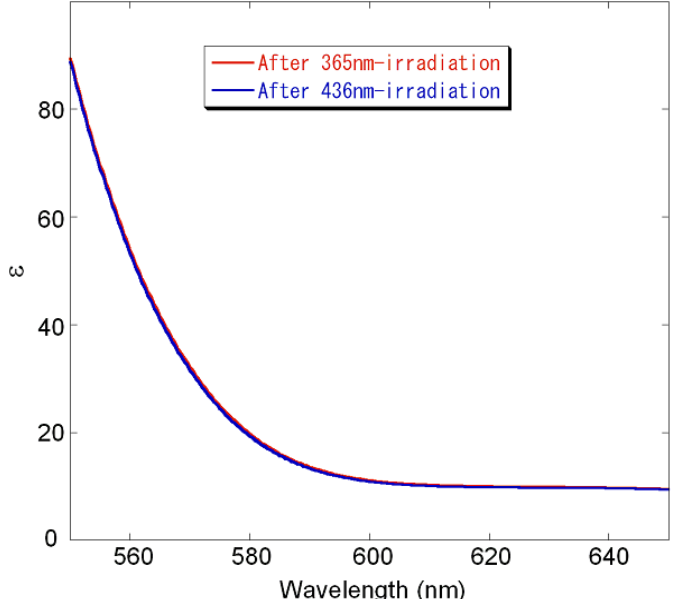
Figure 7. Absorption spectra of concentrated ( R )- 2 after photo-irradiation; after 365 nm- irradiation (blue line), after 436 nm-irradiation (red line). Conditions: CHCl (0.01 g/dL), light path length = 10 mm, 20 °C, Irradiation wavelength: 365